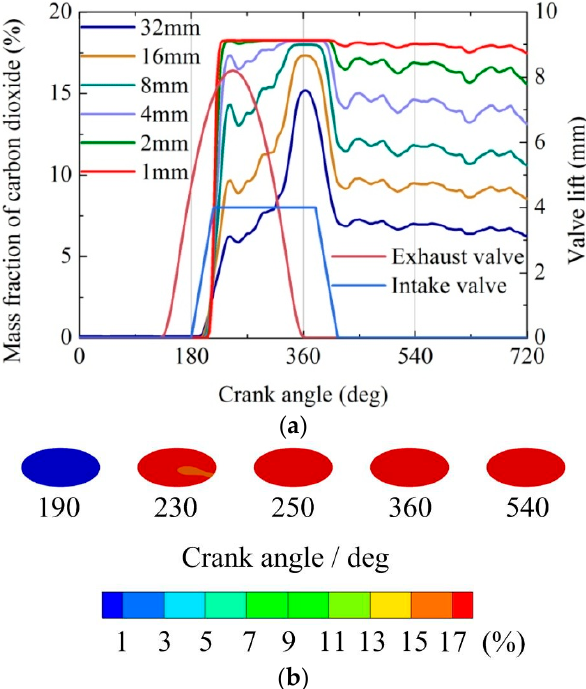
Figure 12. Mass fractions of carbon dioxide: ( a ) 1D simulation; ( b ) 3D calculation.